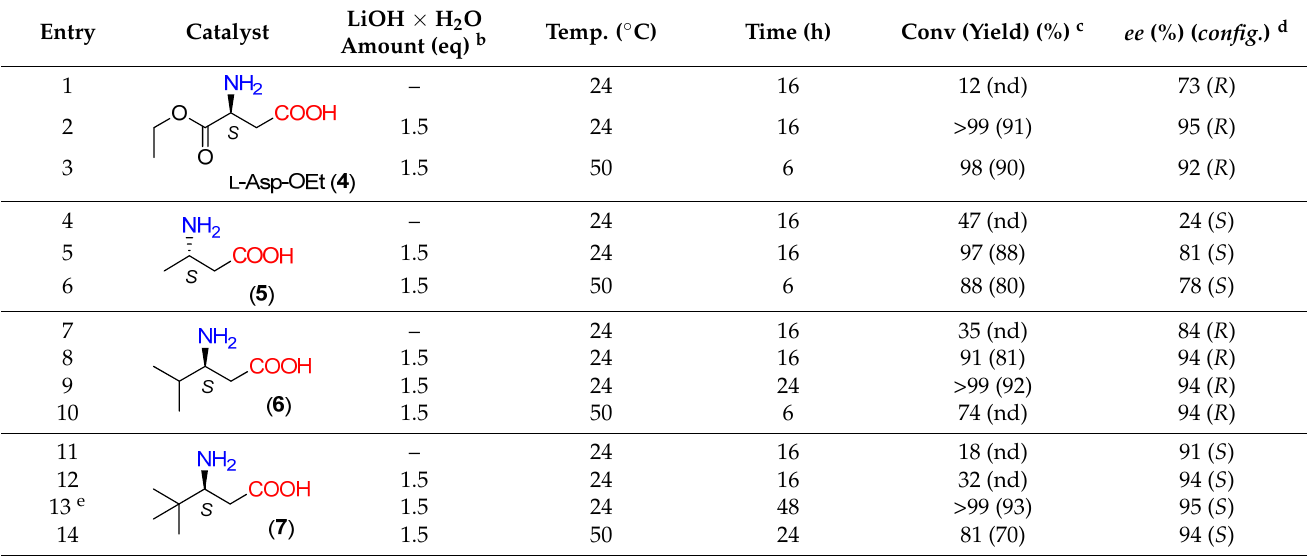
Table 2. Asymmetric Michael addition of 2 to 1a catalysed by β -amino acids 4 – 7 a .